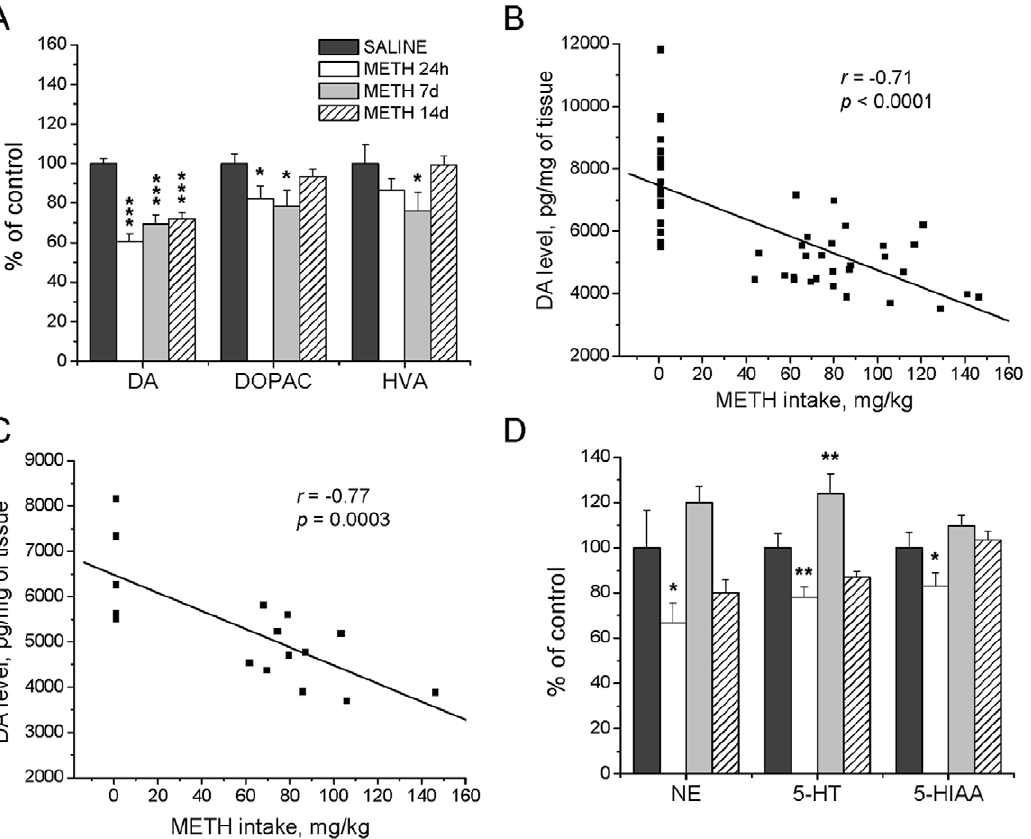
Figure 2. Effects of METH self-administration on monoamine levels in the striatum. METH caused persistent decreases in striatal DA levels (A), which negatively correlated with total drug intake when data at 24 hours, 7 and 14 days after cessation of self-administration were combined (B) and at 14 days post-drug (C). However, only transient changes were found in the levels of NE and 5-HT (D). Data shown as mean 6 SEM. *, p , 0.05; **, p , 0.01; ***, p , 0.001 vs control. Data were analyzed by ANOVA followed by PLSD, n=7 2 11 per group. Correlation analysis was done by regression analysis.